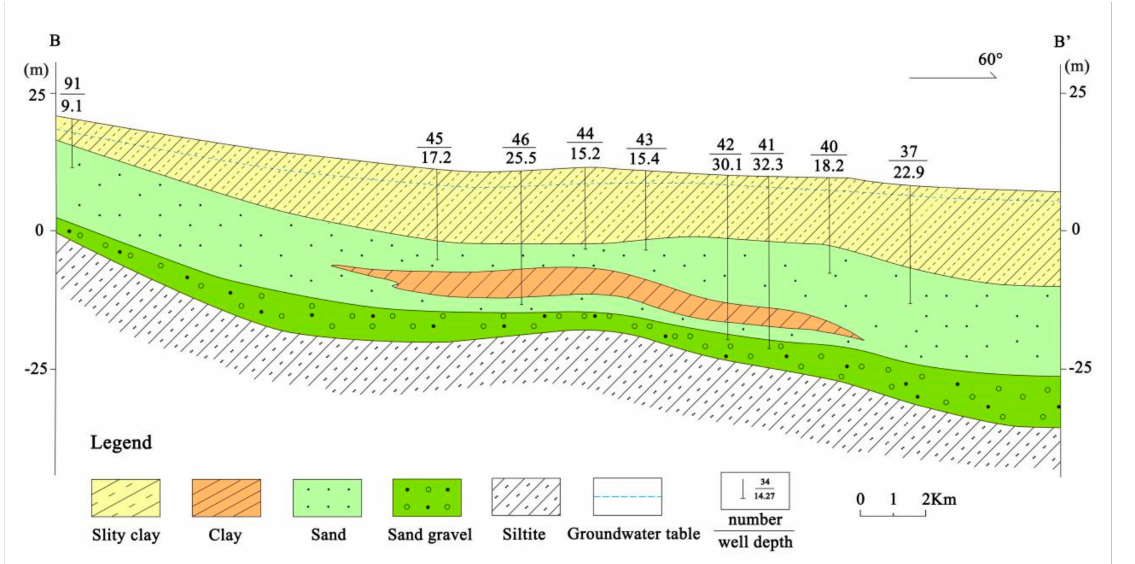
Figure 3. Hydrogeologic cross sections along the B–B’ transect in Figure